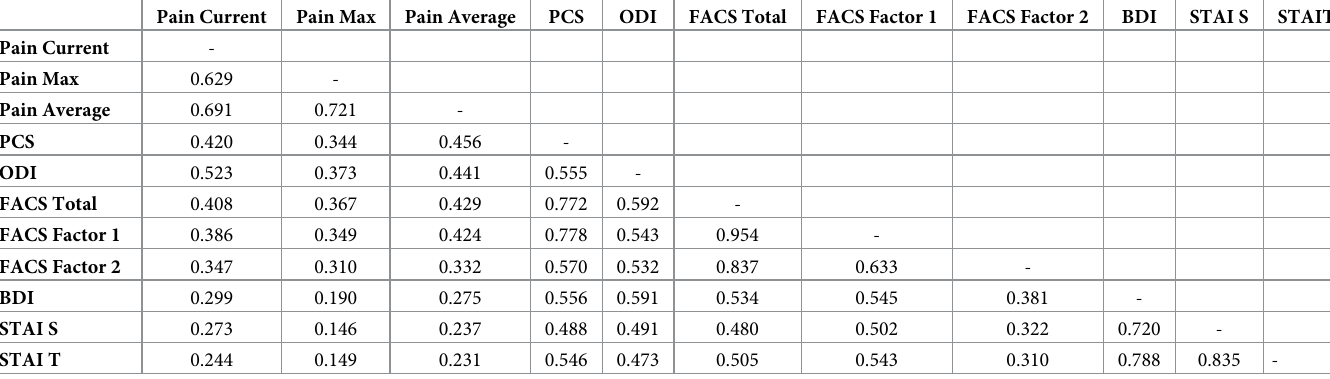
Table 5. Correlations among patient-reported